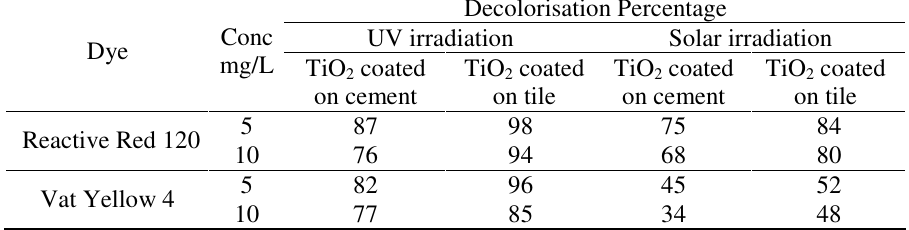
Table 1. Decolorisation of the dyes under UV and solar irradiation by TiO immobilised on cement and ceramic